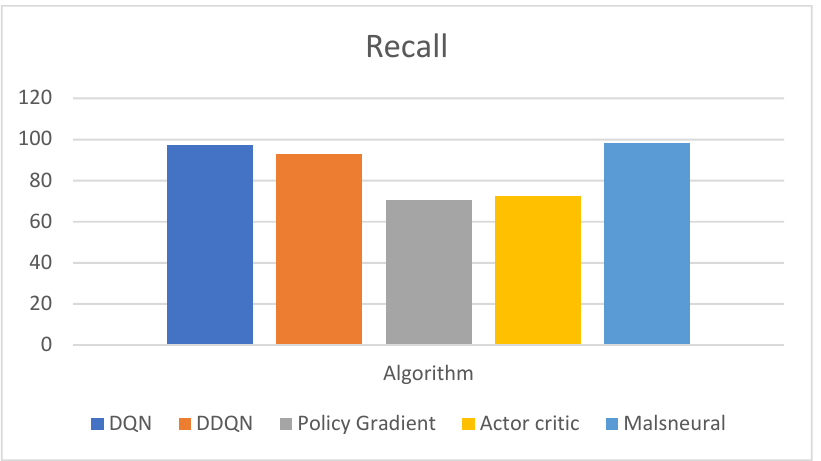
Table 12. Recall calculation for monkeypox disease detection results using the reinforcement learn- ing approach.